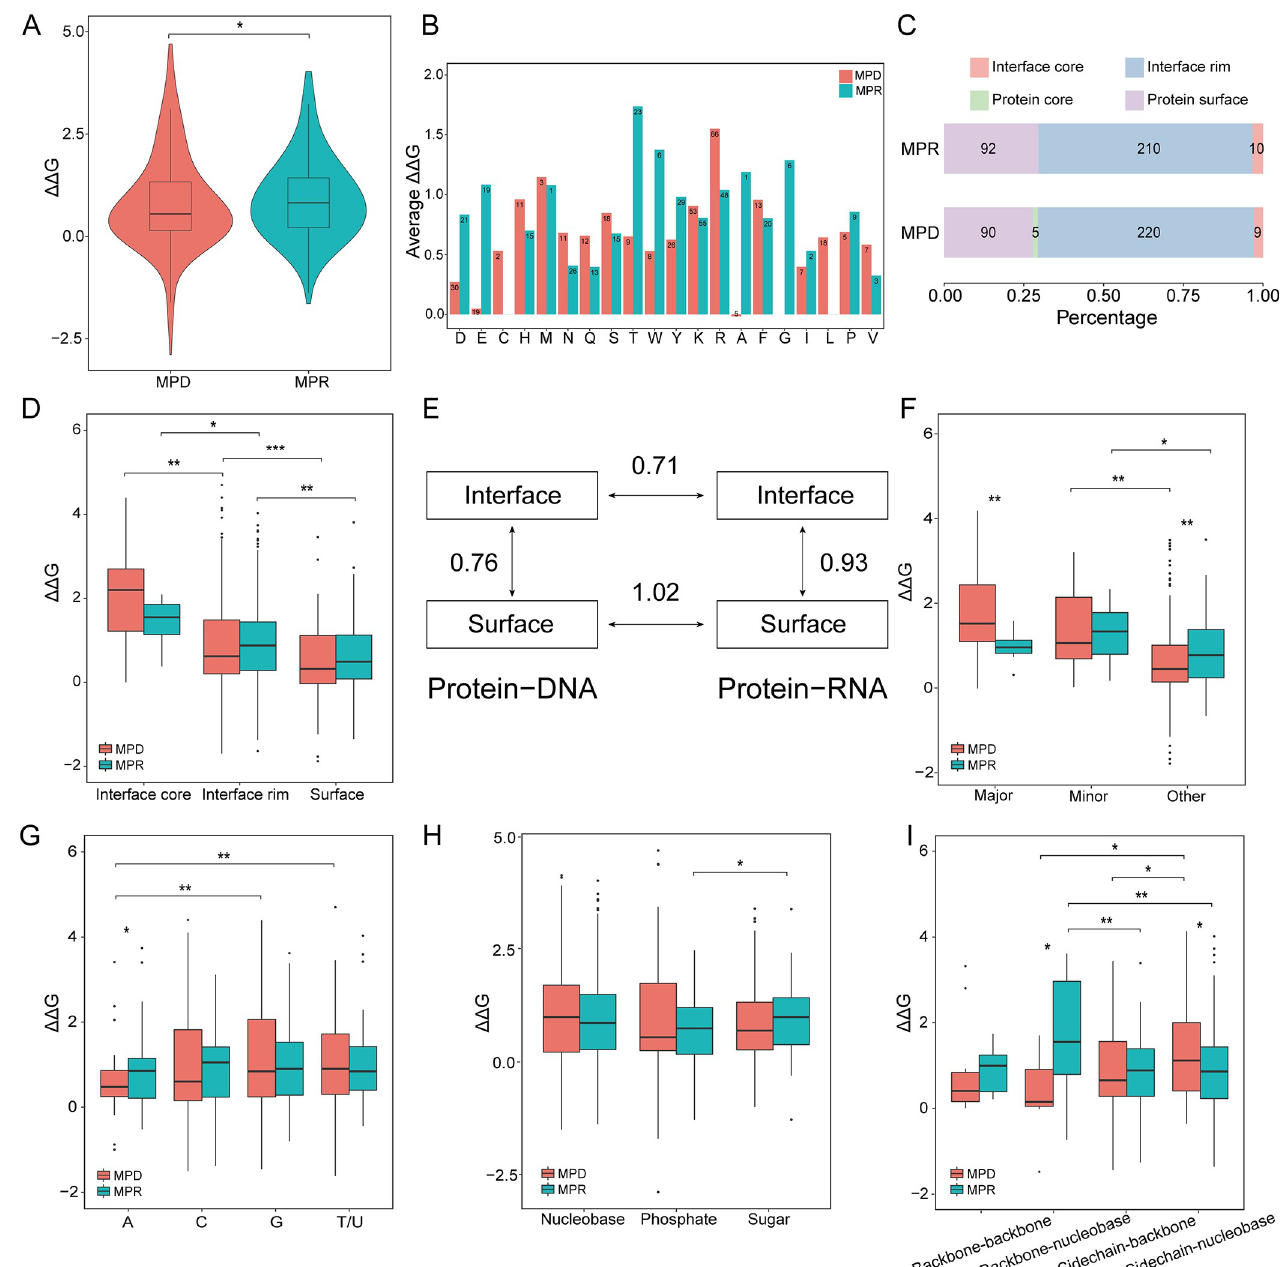
Fig 2. Comparison of binding affinity changes induced by MPDs and MPRs. (A) Overall comparison of MPDs and MPRs. (B) Comparison of MPDs and MPRs based on residue types. The numbers of mutations are shown in the columns. (C) Distribution of MPDs and MPRs in different geometric locations. (D) Comparison of MPDs and MPRs based on geometric locations. (E) Distances between different mutation groups. (F) Comparison of MPDs and MPRs interacting with major or minor grooves. (G-I) Comparison of MPDs and MPRs based on their major binding modes (i.e., the major interacting nucleotides (G), the major interacting subunits of nucleotides (H), and the major interacting contacts between the target residue and nucleotides (I)). For example, the major interacting nucleotides represent that the atomic contacts between a specific type of nucleotides and the target residue account for the greatest proportion among all contacts involving this residue. ��� P < 0.001, �� 0.001 � P < 0.01, and � 0.01 � P < 0.05.